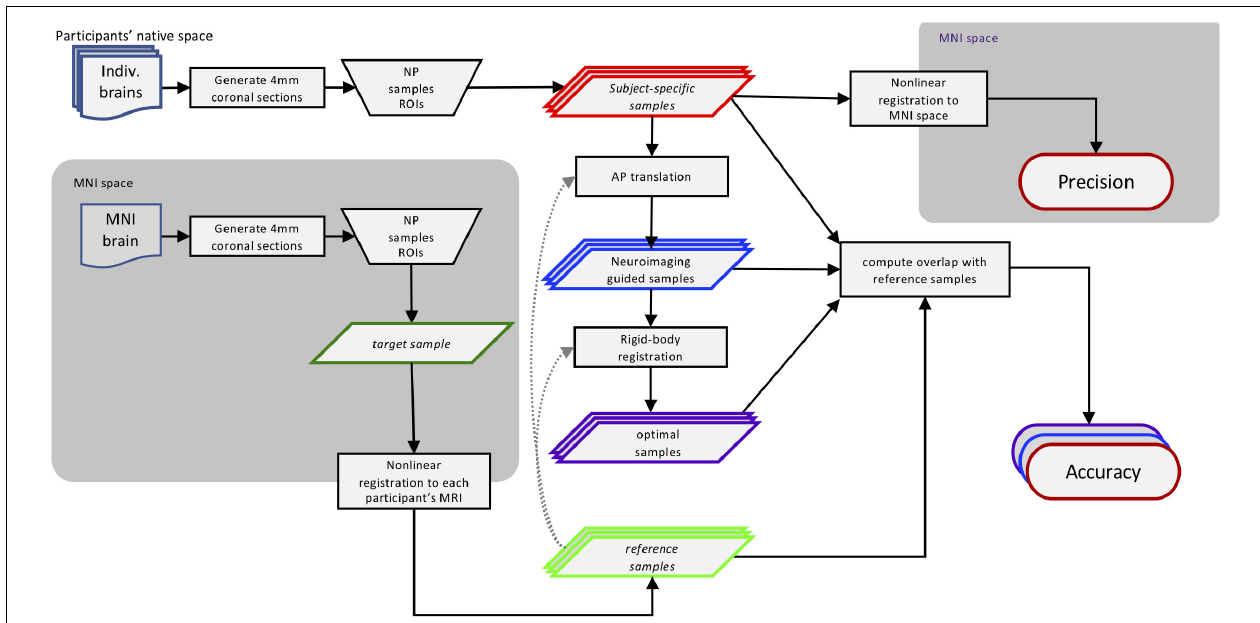
FIGURE 1 | Methods workflow diagram. This diagram illustrates how the different sampling strategies were applied and then compared. Using traditional neuropathologic sampling approaches, the neuropathologist (NP) selected Regions of Interest (ROIs) in both subjects’ native MRI space ( subject-specific samples) and standard MNI space ( target samples). The target samples were then aligned to each subject’s native MRI space to form the reference samples. Translating the subject-specific sample to achieve maximal overlap with the reference samples resulted in the neuroimaging-guided samples and using rigid-body registration to find the highest overlap regardless of slice created the optimal samples. The overlap of the subject-specific samples from all subjects aligned in MNI space was used to evaluate the precision of traditional neuropathologic sampling. The overlap of all three sampling strategies methods with the reference samples was used to evaluate and compare sampling accuracy. Not shown: the functional connectivity patterns of the original subject-specific and references samples were compared to assess the potential impact of sampling variability. MRI, magnetic resonance imaging; MNI, Montreal Neurological